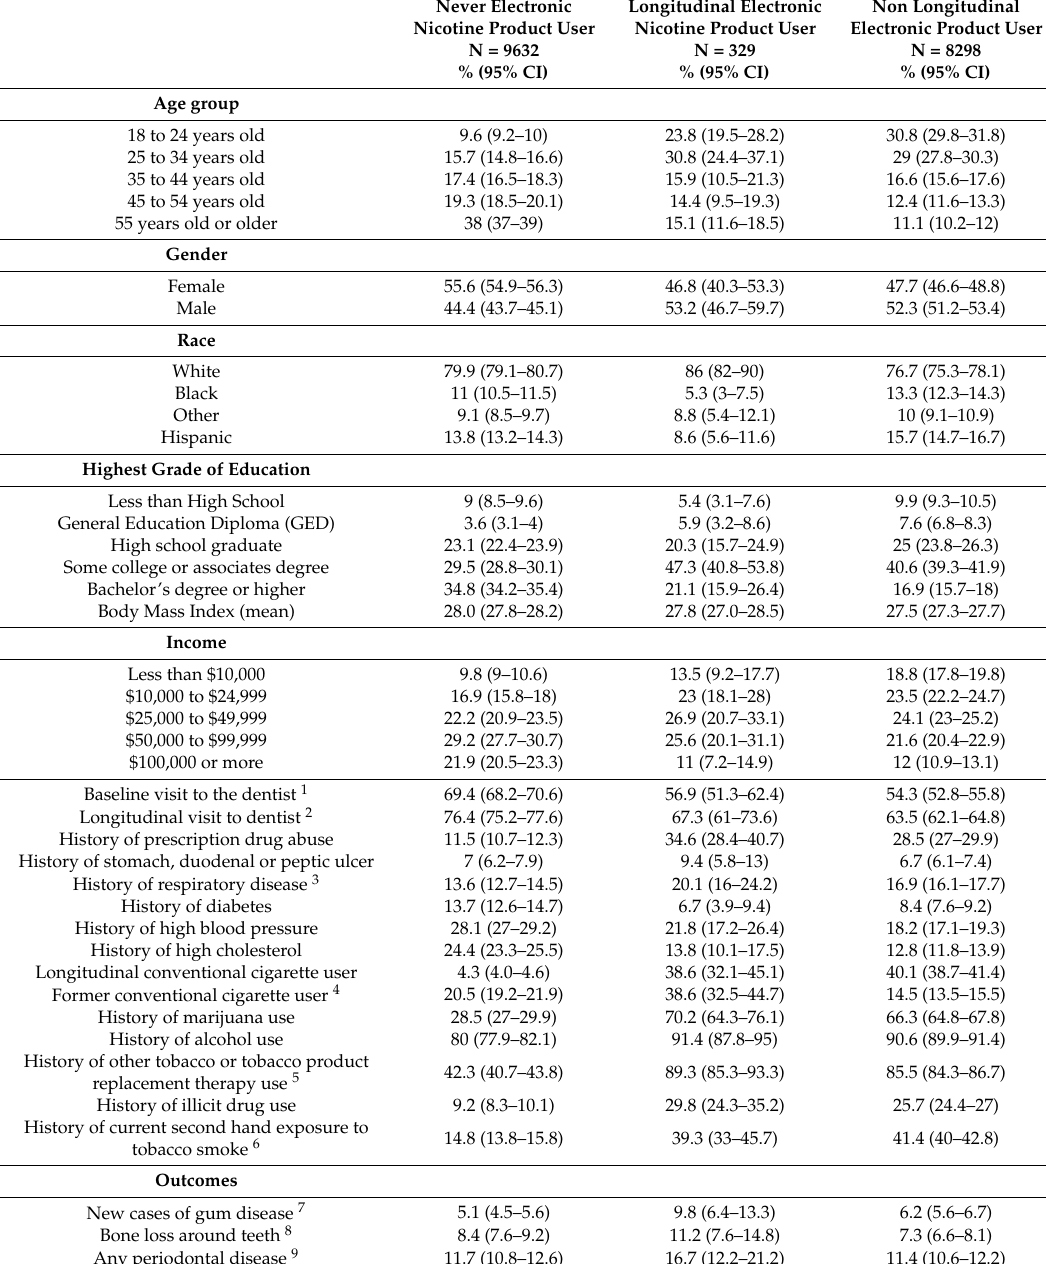
Table 1. Demographic characteristics and health history of adult electronic nicotine product users and controls at baseline (wave